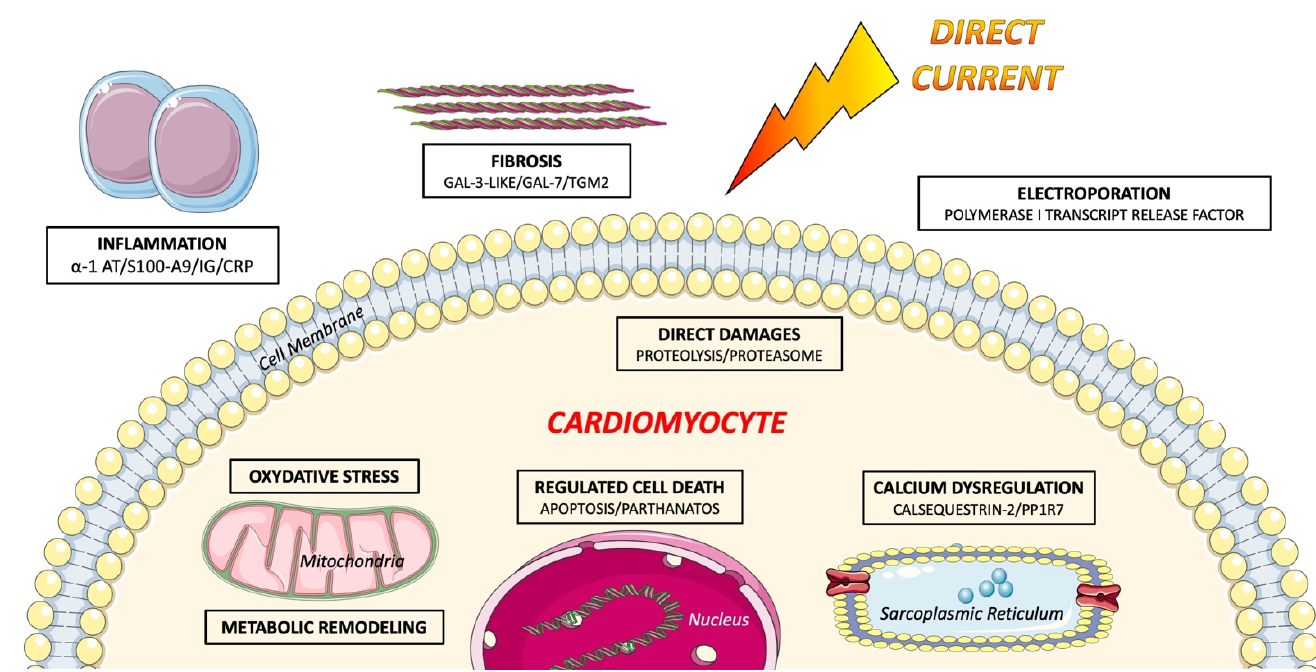
Figure 3. Mechanisms of shock-related myocardial injury identified through a new proteomics approach [94]. Direct current induces electroporation of cardiolemma and direct cellular damages, but also promote regulated cell death, metabolic remodeling, oxidative stress, and calcium dysregulation. Proinflammatory and profibrotic pathways have also been identified.